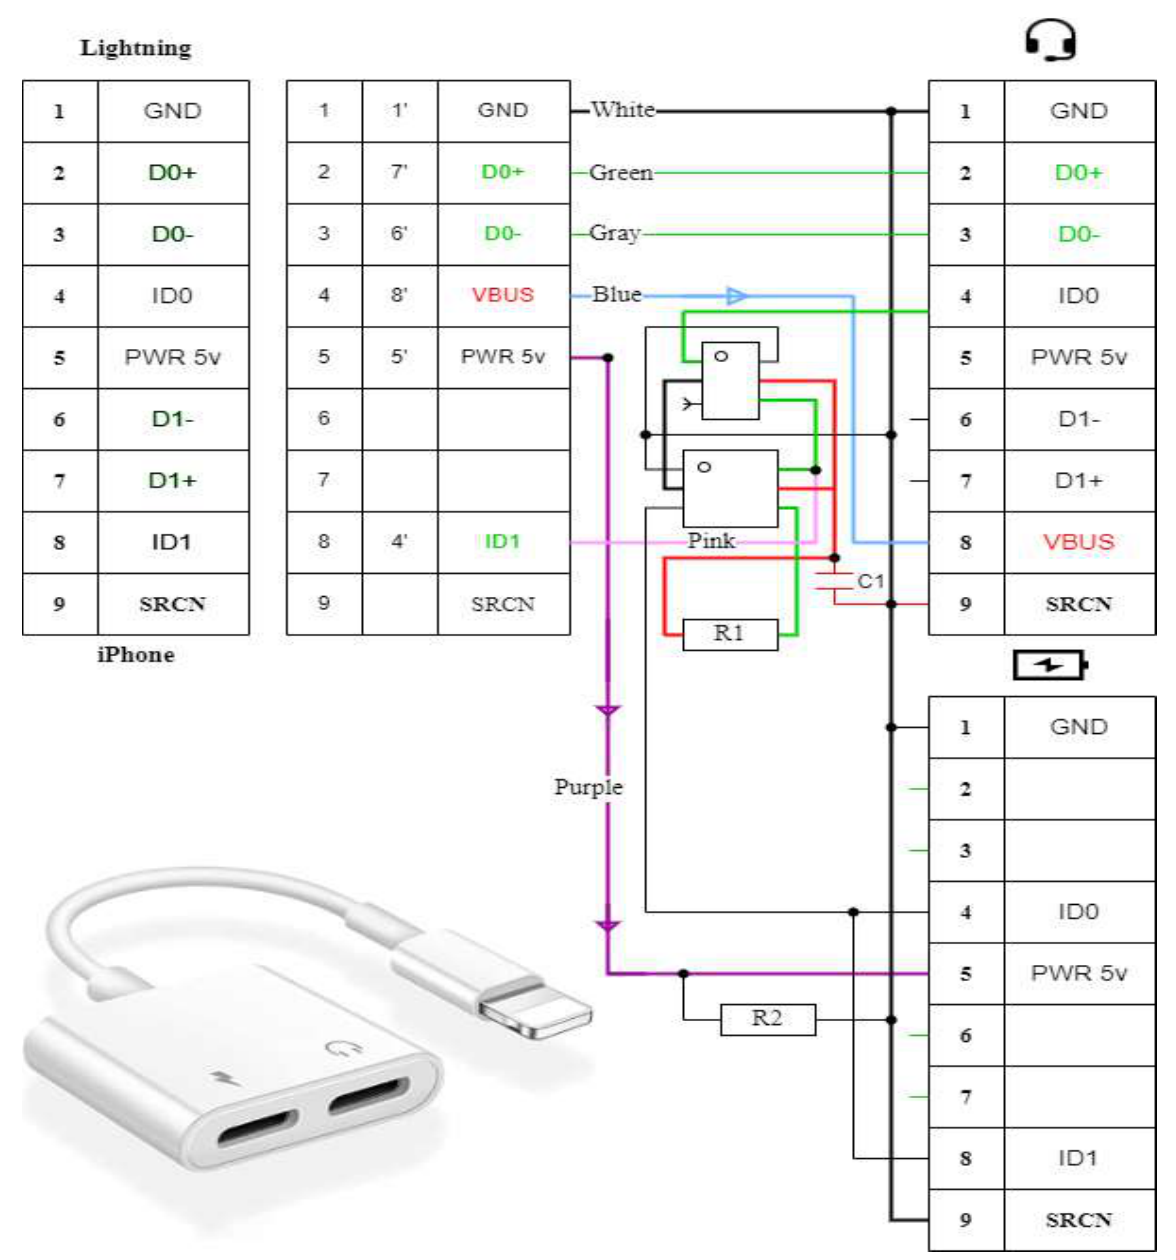
Scheme 2. Inside Scheme of the Lighting multifunctional